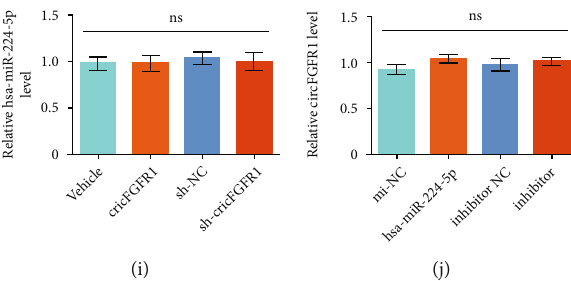
Figure 3: circFGFR1 increases CXCR4 level through sponging to hsa-miR-224-5p. (a) The intersection of predicted miRNA targeting circFGFR1 and CXCR4 according to Starbase database. (b) miRNAs binding with circFGFR1 in SNB19 cells analyzed by circRIP assay. (c) The luciferase activity of pLG3-circFGFR1 in the SNB19 cells after cotransfection with miRNAs. (d) Putative binding sites of hsa- miR-224-5p with respect to circFGFR1 and CXCR4 3 ′ -URT were predicated via Starbase. (e) The luciferase activity of pLG3-circFGFR1 or pLG3-CXCR4 3 ′ -UTR in the SNB19 cells after cotransfection with hsa-miR-224-5p. (f) The RNA enrichment of circFGFR1, hsa-miR- 224-5p, and CXCR4 in SNB19 cells after immunoprecipitated with anti-AGO2 antibody using RIP assay. (g) The RNA enrichment of circFGFR1, hsa-miR-224-5p, and CXCR4 in SNB19 cells using RNA pull-down assay. SNB19 cells were transfected with biotin-labeled mi-NC or hsa-miR-225-5p and pull down with streptavidin agarose beads. (h) The luciferase activity of pLG3- CXCR4 3 ′ -UTR in the SNB19 cells after cotransfecting with hsa-miR-224-5p solely or combined with pCDNA3.1-circFGFR1. (i) The expression of hsa-miR- 224-5p in SNB19 cells stable overexpressing Vehicle, circFGFR1, sh-NC, and sh-circFGFR1, respectively, using qPCR. (j) The expression of circFGFR1 in SNB19 cells transfected with mi-NC, hsa-miR-224-5p, inhibitor NC, and inhibitor, respectively, using qPCR. The data are presented as the means ± SD , n = 3 experiments in (b – j), ∗ p < 0 : 05 , ∗∗ p < 0 : 01 , ∗∗∗ p < 0 : 005 .